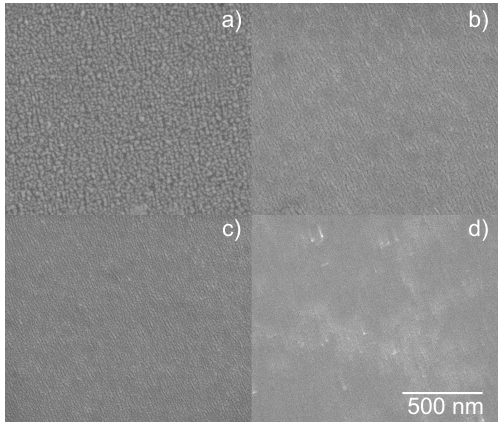
Figure 4. SEM top view of thin films deposited on silicon. Top images ( a , b ) show SEM top view images of non-seeded Ag layers with a nominal thickness of 3 nm and 6 nm, respectively. Bottom images ( c , d ) show SEM top view images of seeded Ag layers with the same nominal thickness as ( a , b ). The Al seed layer has a nominal thickness of 0.5 nm.